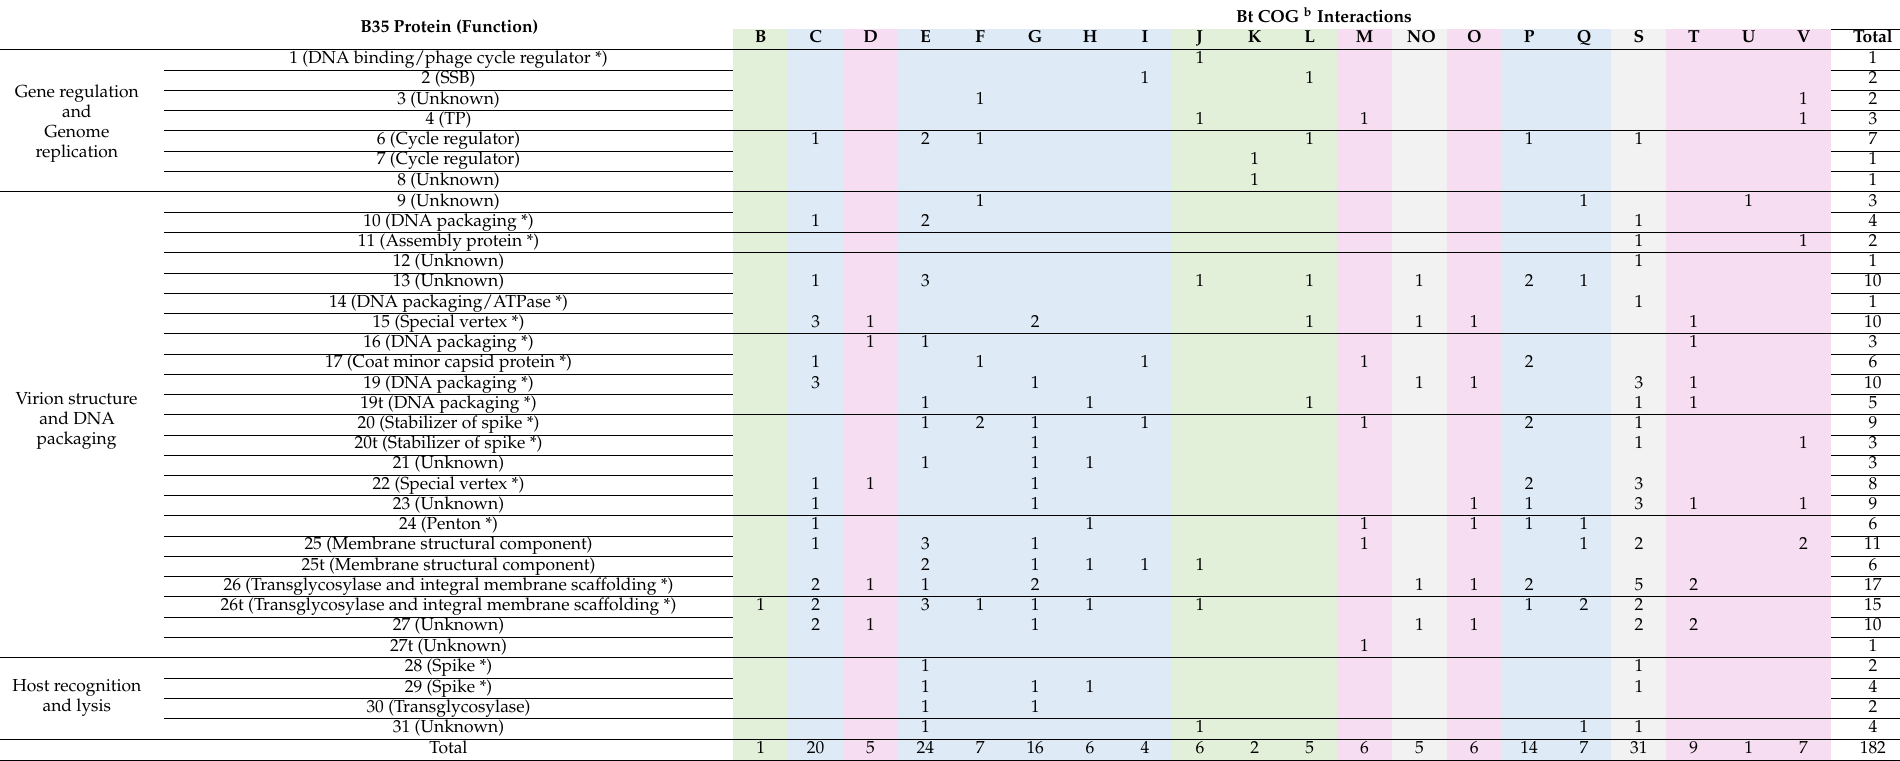
a See Supplementary Table S6 for more detailed information. b Cellular processes and signaling (pink): (D) cell cycle control, cell division, chromosome partitioning; (M) cell wall/membrane/envelope biogenesis; (O) post-translational modification, protein turnover, and chaperones; (T) signal transduction mechanisms; (U) intracellular trafficking, secretion, and vesicular transport; (V) defense mechanisms. Information storage and processing (green): ( B ) chromatin structure and dynamics; (J) translation, ribosomal structure, and biogenesis; (K) transcription; (L) replication, recombination, and repair. Metabolism (blue): (C) energy production and conversion; (E) amino acid transport and metabolism; (F) nucleotide transport and metabolism; (G) carbohydrate transport and metabolism; (H) coenzyme transport and metabolism; (I) lipid transport and metabolism; (P) inorganic ion transport and metabolism; (Q) secondary metabolites biosynthesis, transport, and catabolism. Limited characterization (gray): (S) function unknown, (NO) no category assigned. * Suggested